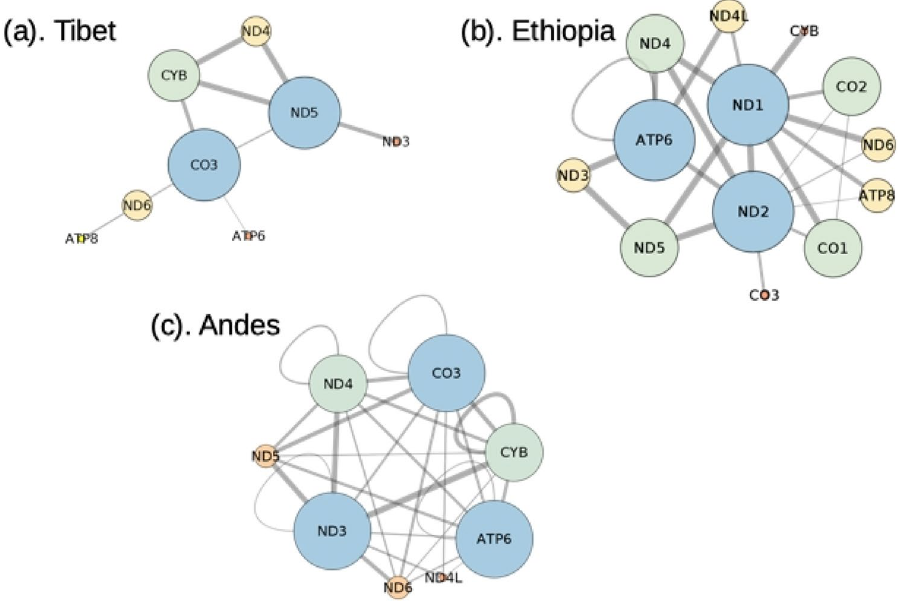
Figure 5. Significant gene–gene interactions of common node co-mutations (the node size depicts the degree of the node and edge size represents the edge weight).